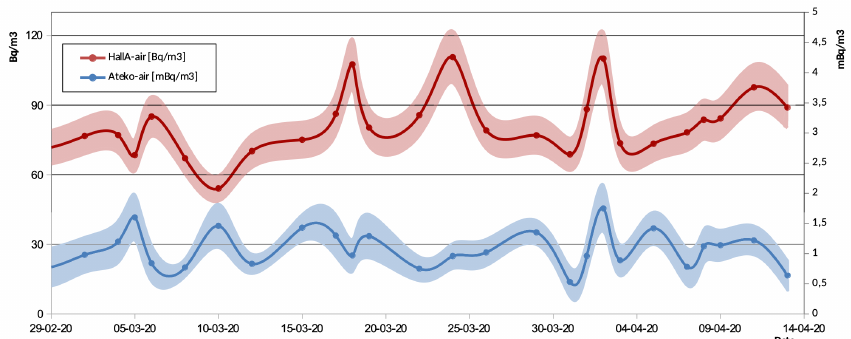
Figure 8. Comparison of radon activities vs time. We show the radon activity in Hall-A measured with an AlphaGuard (in red) in units shown in the left side y -axis and with the ERM (in blue) in units shown in the right side y -axis.